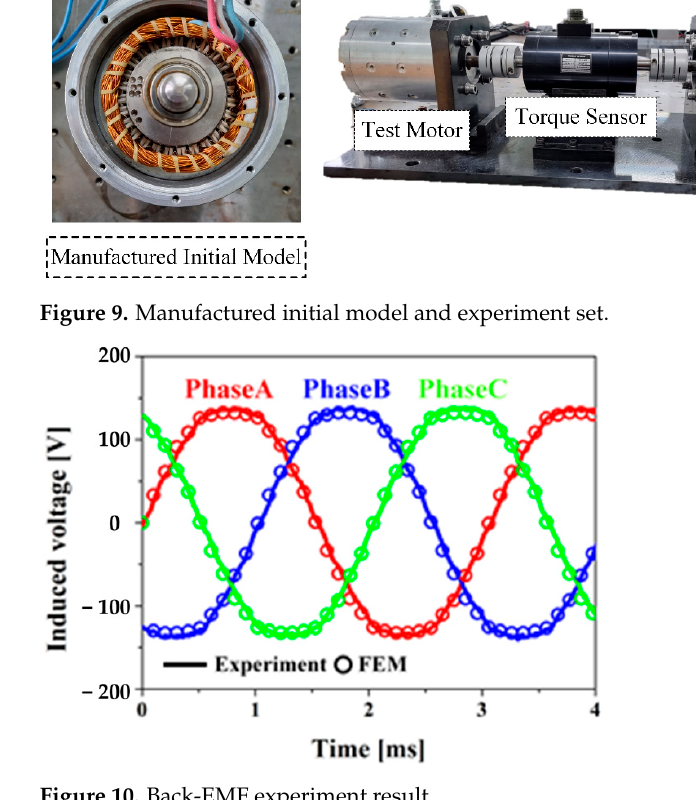
Figure 10. Back-EMF experiment result. Table 3. Efficiency experiment results @Rated point.